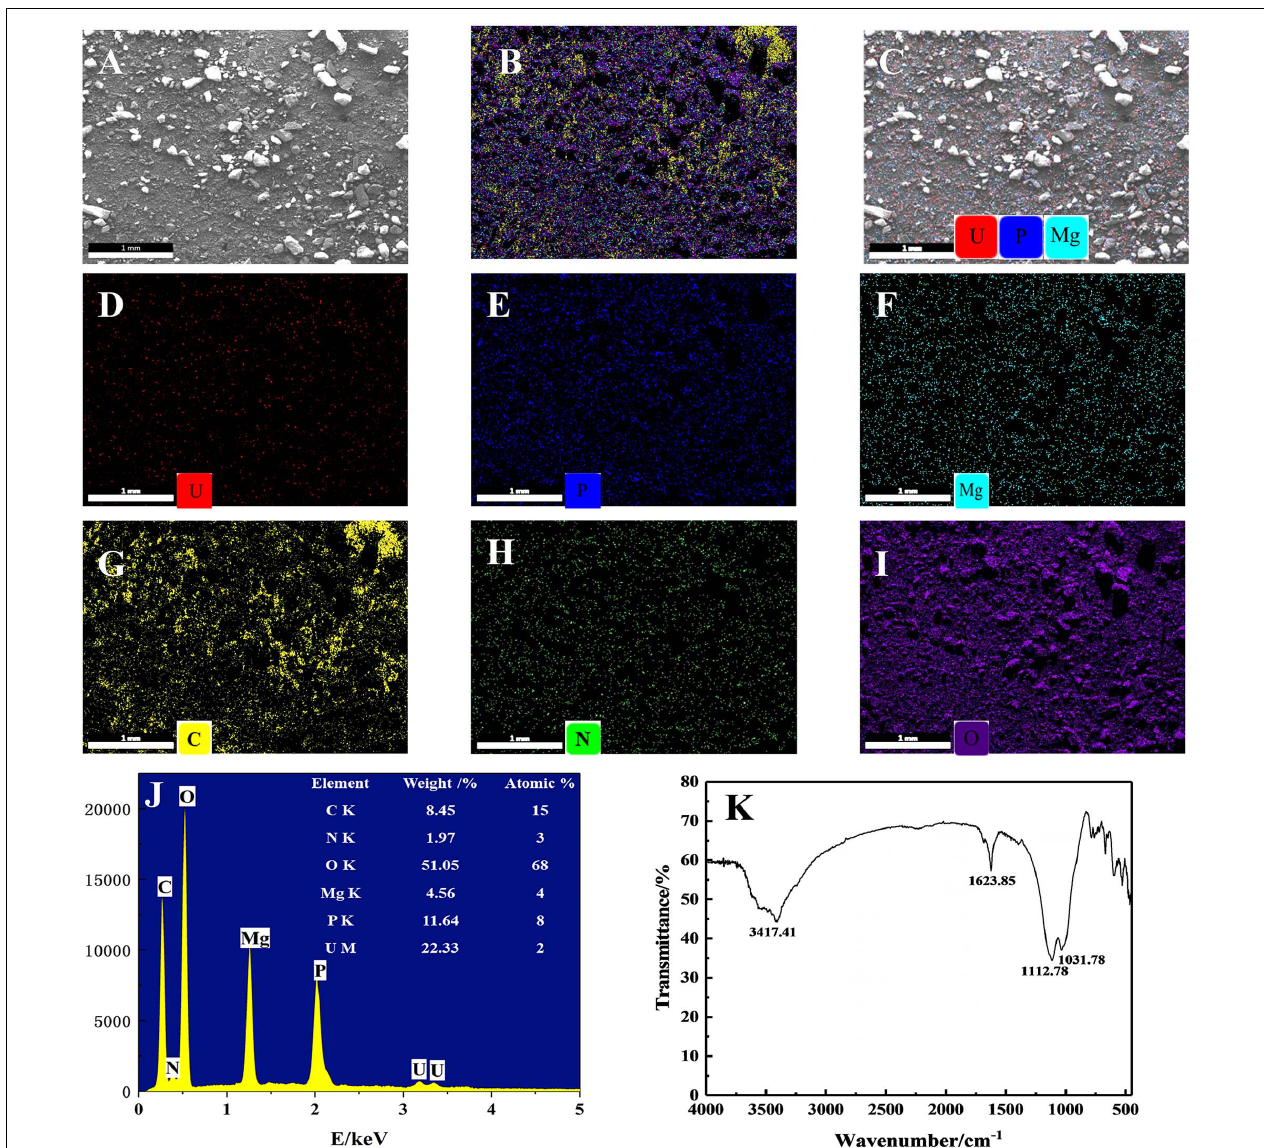
FIGURE 6 | SEM-EDS and FTIR spectra analyses of the precipitates; (A) SEM images of U phosphates precipitates and (B) their corresponding EDS maps with the distribution of (C) P + U + Mg + C + N + O, (D) P + U + Mg, U, (E) P, (F) Mg, (G) C, (H) O, and (I) N. (J) EDS results of the precipitates and (K) FTIR results of the